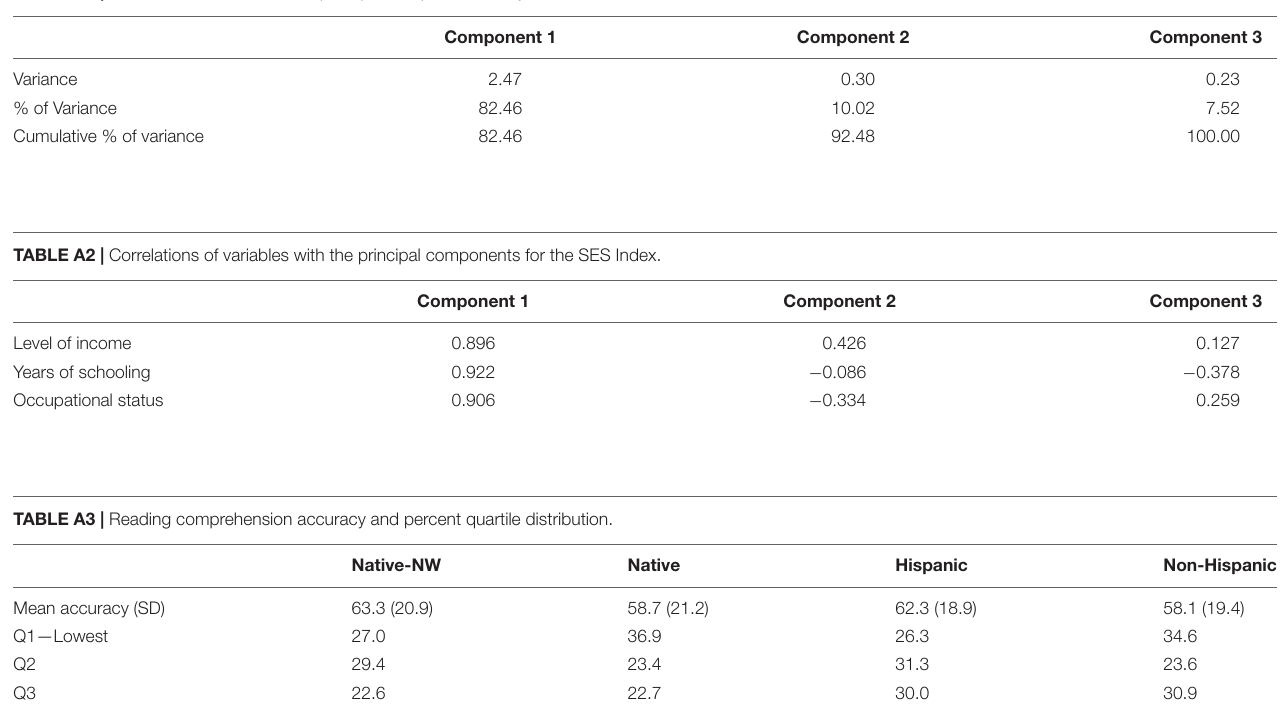
TABLE A1 | Structure coefficients of the principal components analysis for the SES Index.